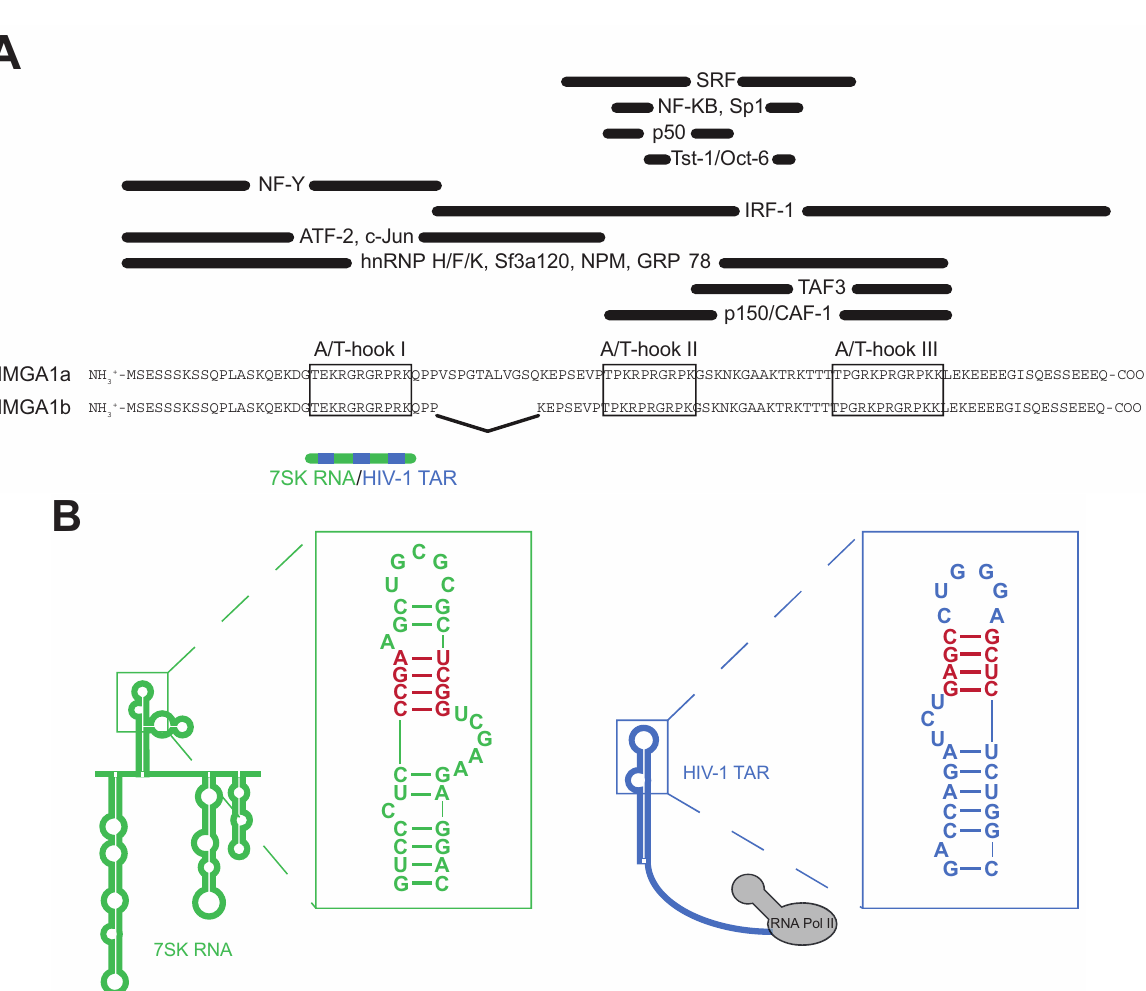
Figure 2. Schematic view of HMGA1 functional domains and RNA interfaces. ( A ) Schematic view of the HMGA1a/b functional domains. Interaction sites with transcription factors are labeled in black, the interface with 7SK and TAR RNA is depicted in blue/green; ( B ) Secondary structures of 7SK Loop2 (green) and HIV-1 TAR RNA (blue). The specific HMGA1-binding structures are highlighted in